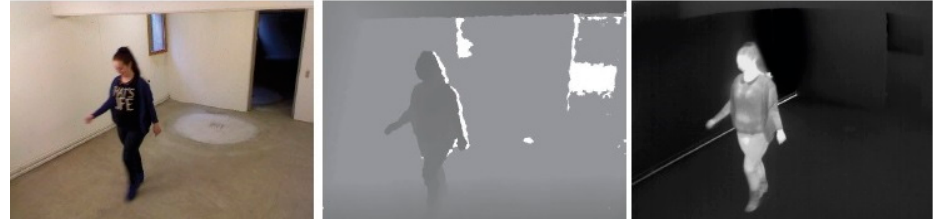
Figure 14. Sample images showing three modalities (RGB, depth, and thermal) taken from the RGB-D-T dataset.